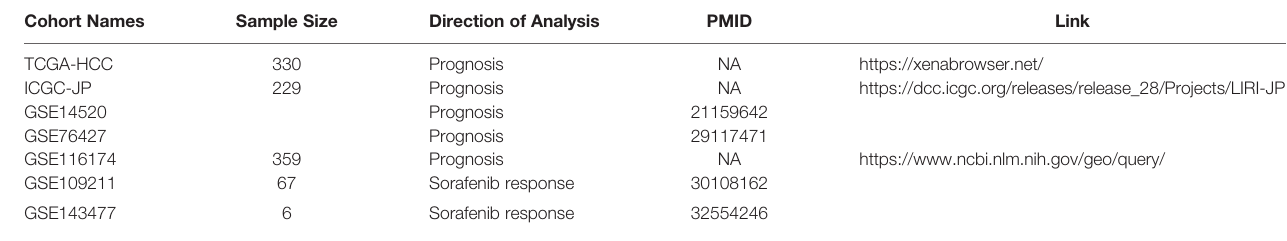
TABLE 1 | Information regarding the HCC cohorts used in this